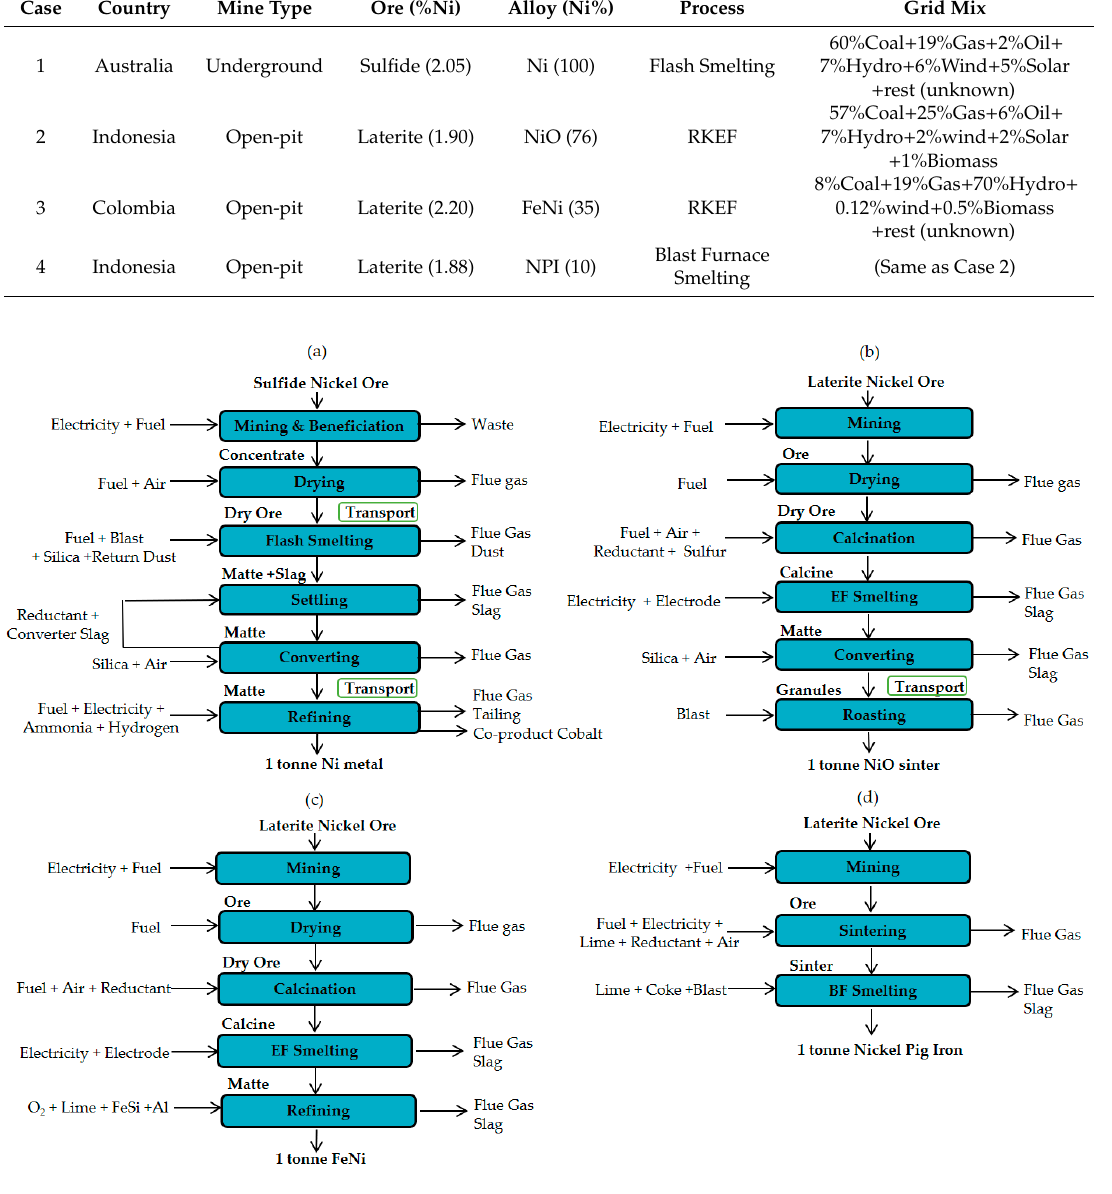
Figure 1. Process flows and system boundaries of four smelting products: ( a ) Case 1- Ni metal, ( b ) Case 2-NiO, ( c ) Case 3-FeNi and ( d ) Case 4-NPI.